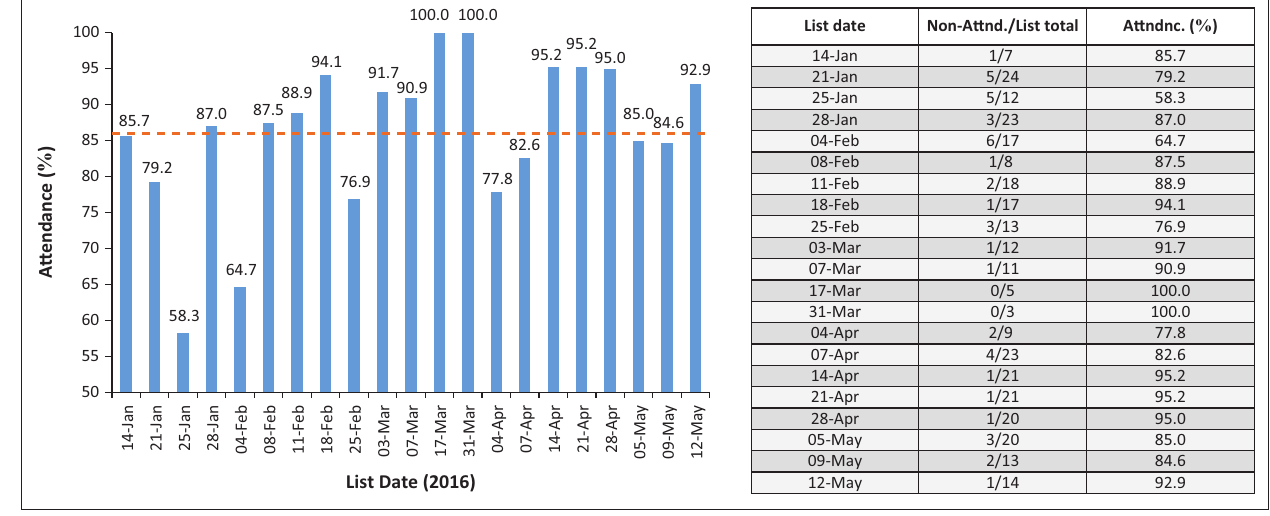
FIGURE 1: Percentage attendance for each surgical list at Good Shepherd Hospital Eye Clinic between 14 January 2016 and 12 May 2016 ( n = 311; 23 lists, 311 patients booked onto a list, 41